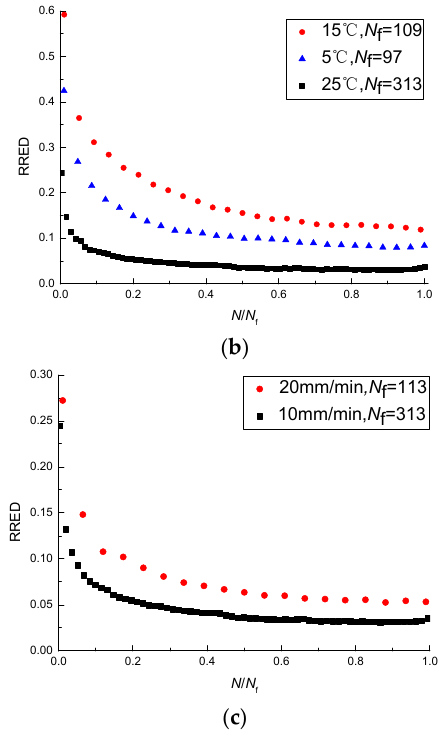
Figure 7. RREDs under different test conditions: ( a ) RREDs at different stress-strength ratios; ( b ) RREDs at different temperatures; ( c ) RREDs at different loading rates.